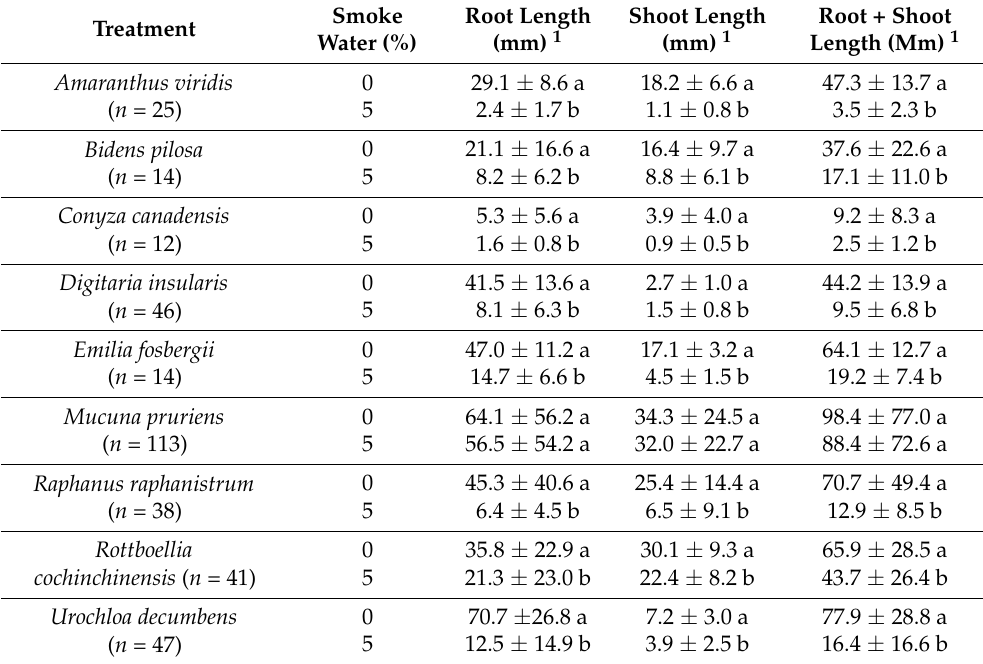
Table 3. Effects of smoke solution on seedling growth of weeds under a 12 h photoperiod at 25 ◦ C.